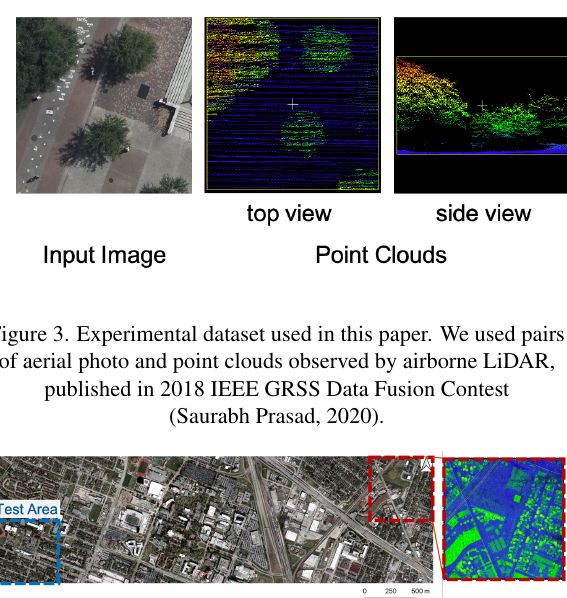
Figure 2. Given a latent feature z from input image X using encoder E , the generator G produces a point cloud y fake . The real point cloud y real and the generated fake point cloud y fake are fed into the discriminator which then tries to predict the probability of the data being real data or generated fake data. The encoder is pre-trained ResNet-50, the decoder is FoldingNet, and the discriminator is PointNet++. These models are trained in an end-to-end manner.